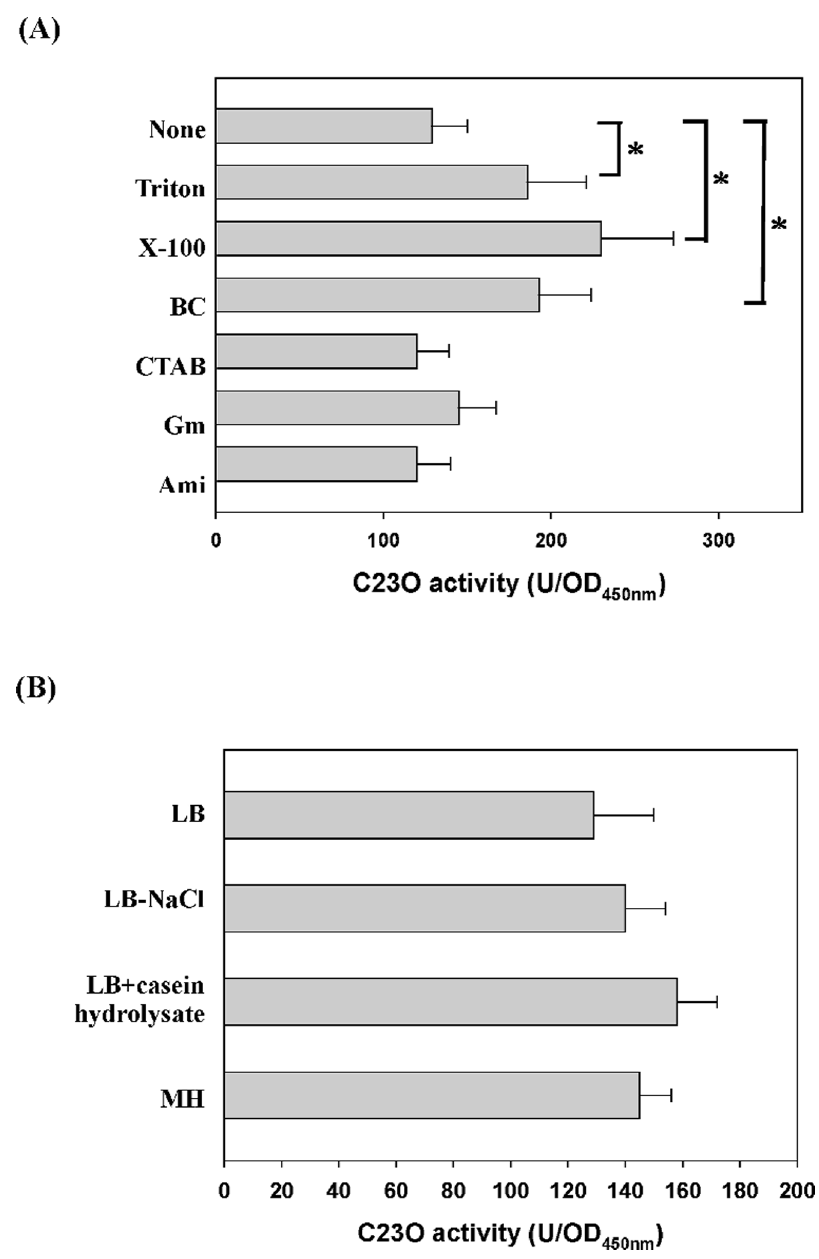
Figure 5. The expression of smeIJK operon in different stresses and culture media. Plasmid containing a transcriptional fusion of the upstream region of smeI to the xylE gene (pSmeI xylE ) was transferred into the wild-type KJ. The C23O activities of the logarithmic-phase cultures of KJ(pSmeI xylE ) were determined. Each bar represents the mean of three independent experiments. Each bar represents the mean of three independent experiments. *, p # 0.01 significance calculated by a Student’s t -test. (A) The expression of smeIJK operon in different stresses. The concentrations of the stressors added were: Triton X-100, 100 m g/ml; benzalkonium chloride (BC), 10 m g/ml; cetyltributylammonium bromide (CTAB), 10 m g/ml; gentamicin (Gm), 1 m g/ml; amikacin (Ami), 1 m g/ml; and leucomycin (Leu), 0.5 m g/ml. (B) The expression of smeIJK operon in different culture media, including the LB, the LB without NaCl, the LB with casein hydrolysate, and the MH.